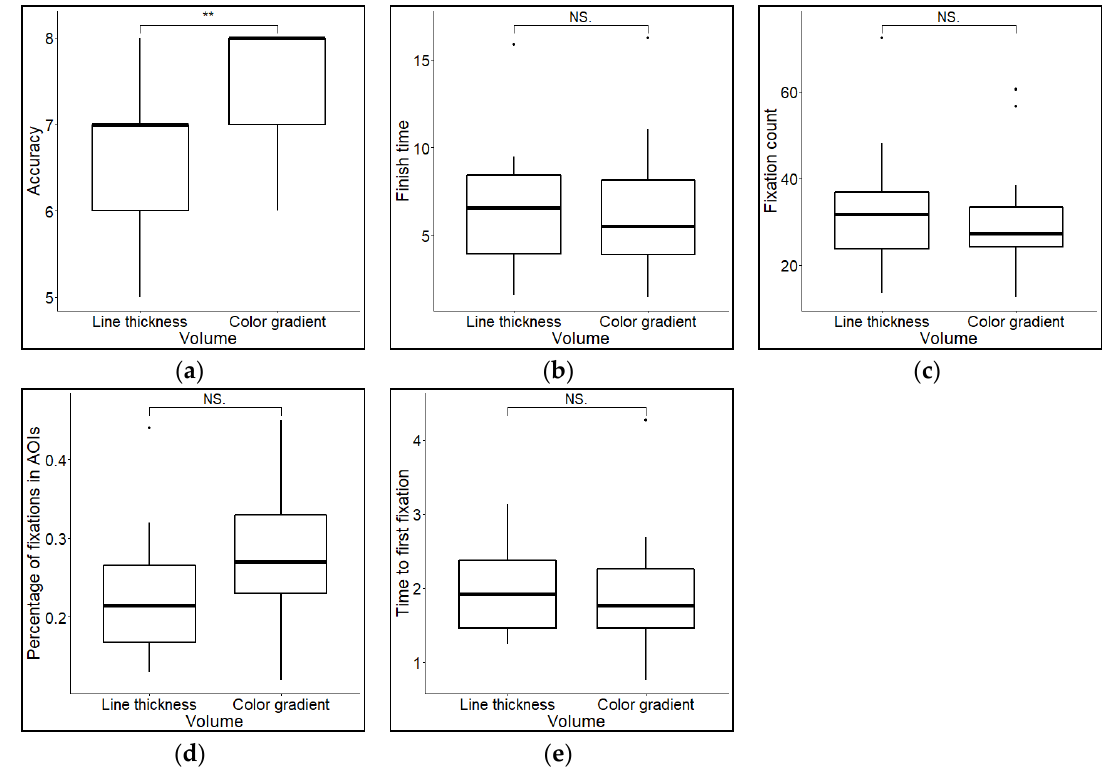
Figure 4. Statistics for the two different representations of the flow volume and Mann-Whitney U test results (** p < 0.01 and NS = not significant). ( a ) Accuracy; ( b ) finish time; ( c ) fixation